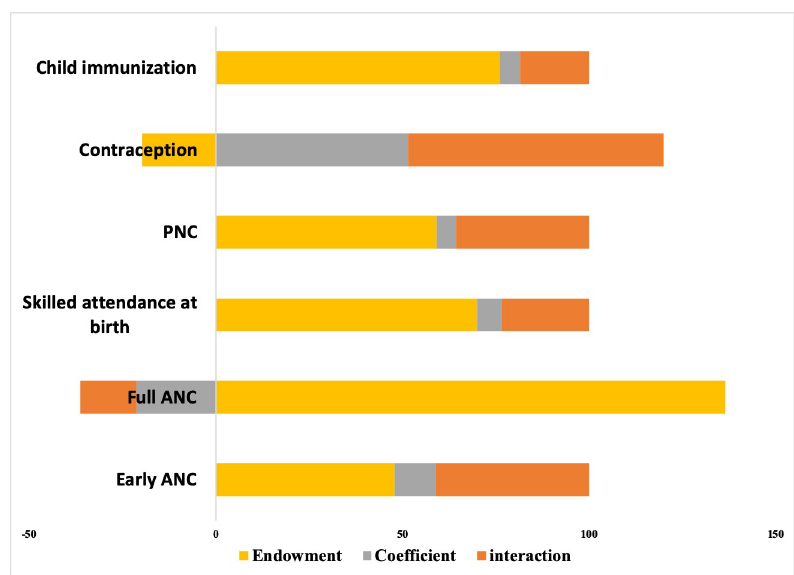
Fig 5. Blinder-Oaxaca decomposition plot explaining differences in health care utilization indicators between women with and without phone